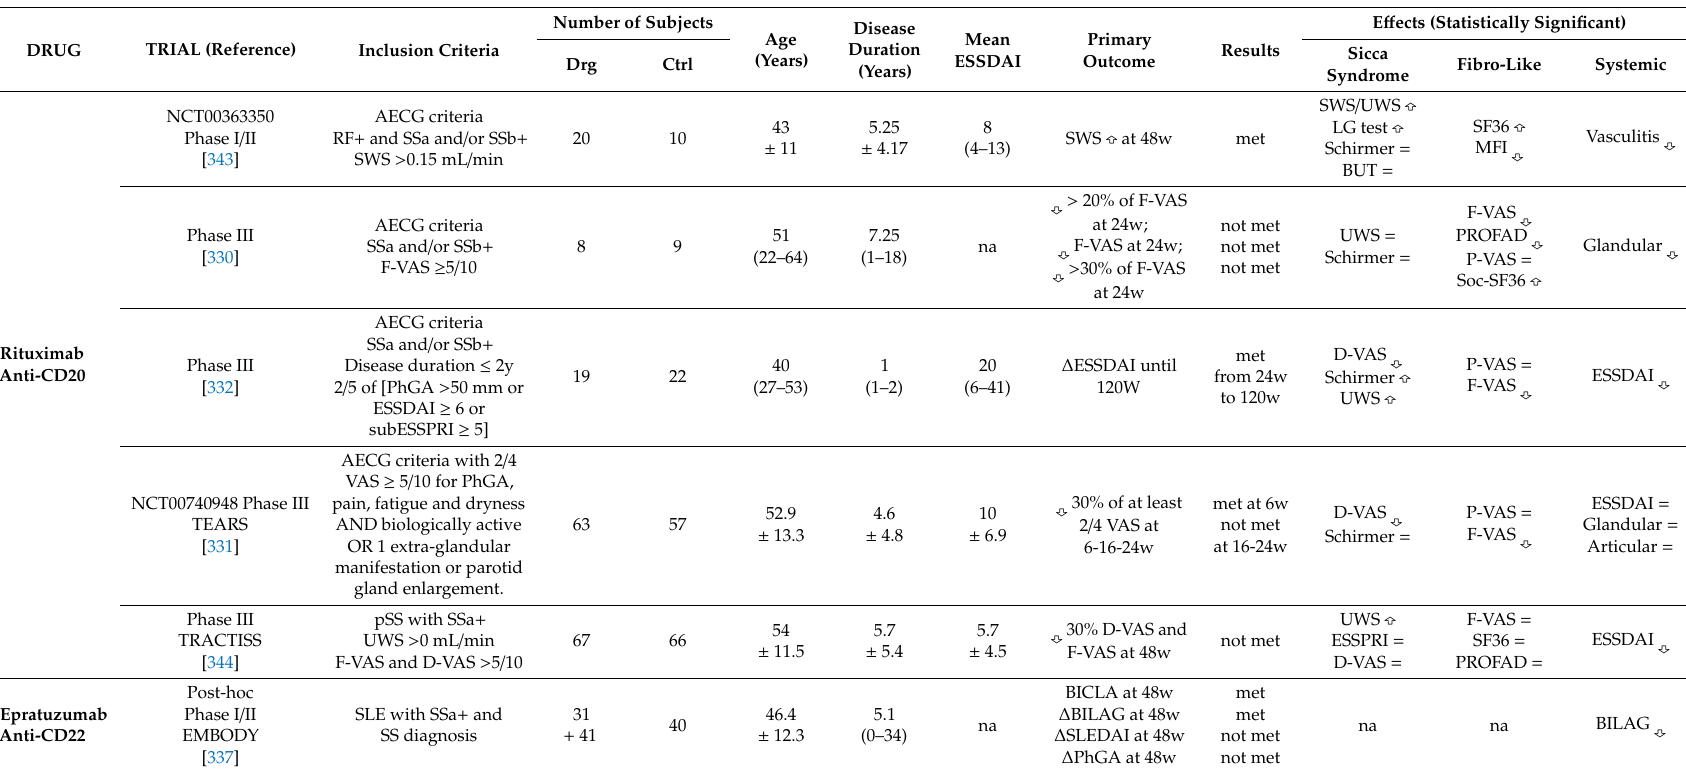
SLE with SSa + and SS